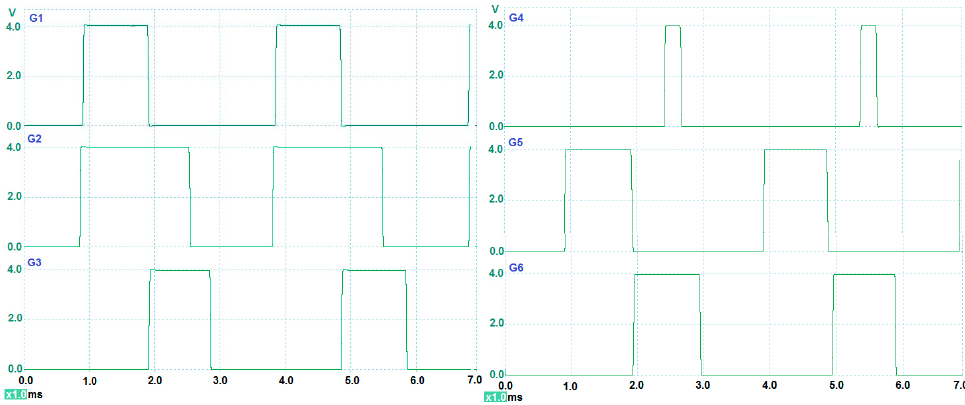
Figure 25. Arduino pulses with appropriate pulse widths to allow for adaptive control of AC/DC converter.